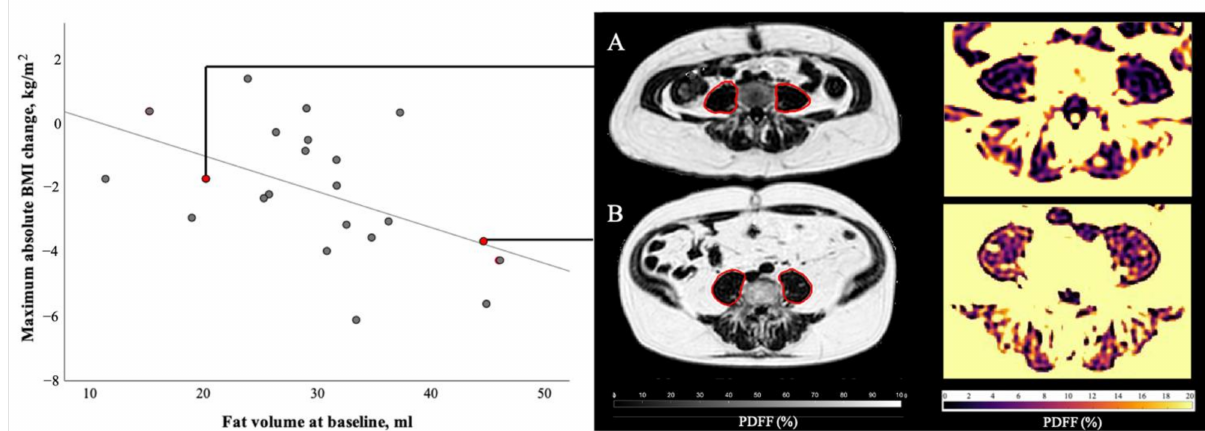
Figure 5. Correlation of psoas muscle fat volume at baseline and maximum absolute BMI change during the course of disease. At baseline patient A (female, 48 years old, BMI 26.2 kg/m 2 , suffering from colorectal cancer) presented with 20.2 mL of psoas muscle fat volume, patient B (male, 64 years old, BMI 33.1 kg/m 2 , suffering from ductal adenocarcinoma of the pancreas) with 44.6 mL of psoas muscle fat volume. During the course of this study, patient A lost 1.7 BMI points and patient B lost 3.7 BMI points. Statistical analysis of all 22 patients with follow-ups revealed a significant correlation (r = − 0.51, p = 0.02) between baseline psoas fat volume and maximum BMI change during